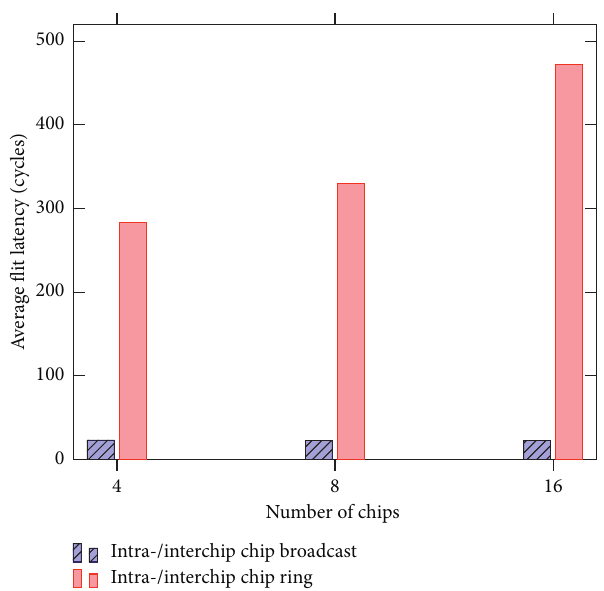
Figure 15: The average latency of the proposed THz multichip system in comparison with the token-based mm-wave one with varying system size (PIR � 0.001).